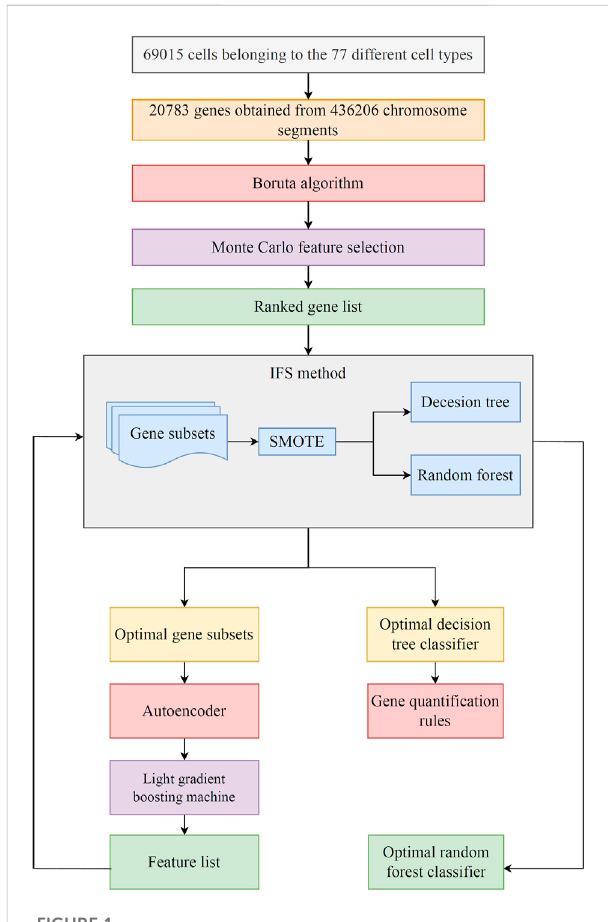
FIGURE 1 Flowchart of the machine learning procedure in this study. The transcriptionally active chromosome segments are identi fi ed by sci- ATAC-seqatsingle-cellresolution,including69,015cellsbelongingto 77 different cell types and 436,206 active chromosome segments mapped to 20,783 genes. The Boruta algorithm is used to fi lter genes, and then genes are ranked in accordance with the Monte Carlo feature selection algorithm. Subsequently, the optimal classi fi er and corresponding optimal feature subsets are obtained using incremental feature selection (IFS) and two classi fi cation algorithms. The classi fi cation rules are mined by the optimal decision tree (DT) classi fi er. Finally, the optimal features for random forest (RF) are reconstructed by autoencoder. The reconstructed features are evaluatedbyLightGBM,resultinginafeaturelist.IFSmethod isapplied on such list to set up the fi nal optimal RF classi fi